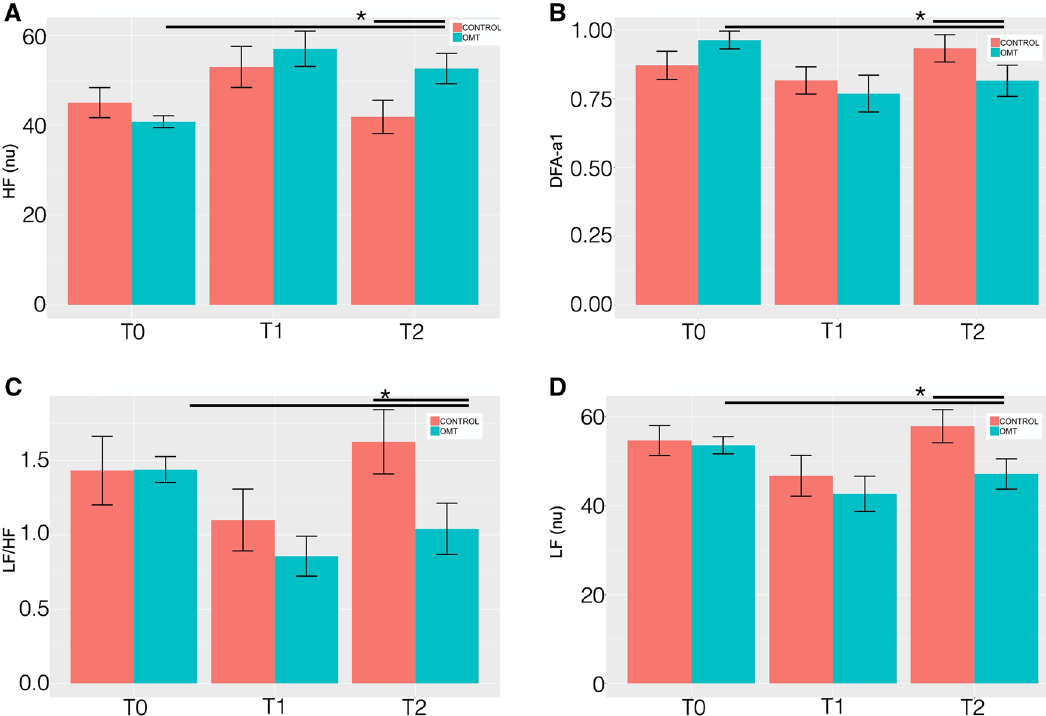
Figure 4. Heart rate variability changes between the study and control group. Heart rate variability (HRV) findings for: ( A ) high frequency (HF) normalised units (nu); ( B ) detrended fluctuation scaling exponent (DFAα1); ( C ) low frequency/high frequency ratio (LF/HF); ( D ) low frequency (LF—nu). Data presented are means ± standard deviation (SD). *Statistically significant differences (p < 0.05) in OMT group compared to sham and control